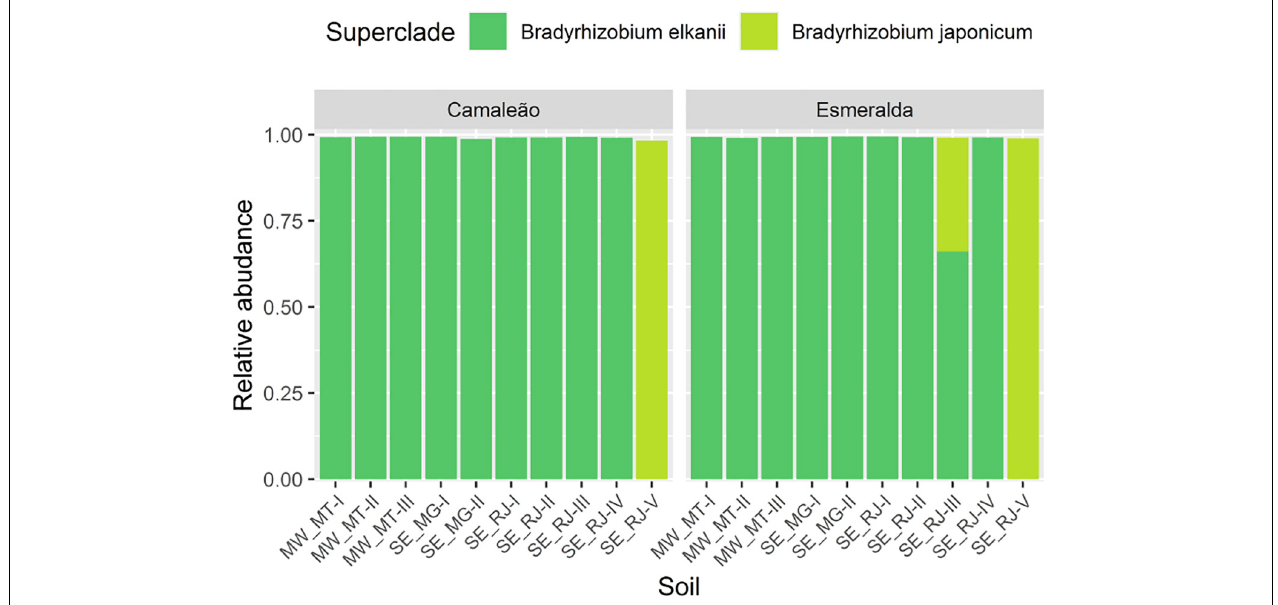
FIGURE 9 | Distribution of the 10 most abundant sequences of OTU0001 and five of OTU0002 belonging to the Bradyrhizobium genus, based on the 16S rRNA gene from nodules of Camaleão and Esmeralda mung bean genotypes cultivated in 10 different soil samples.